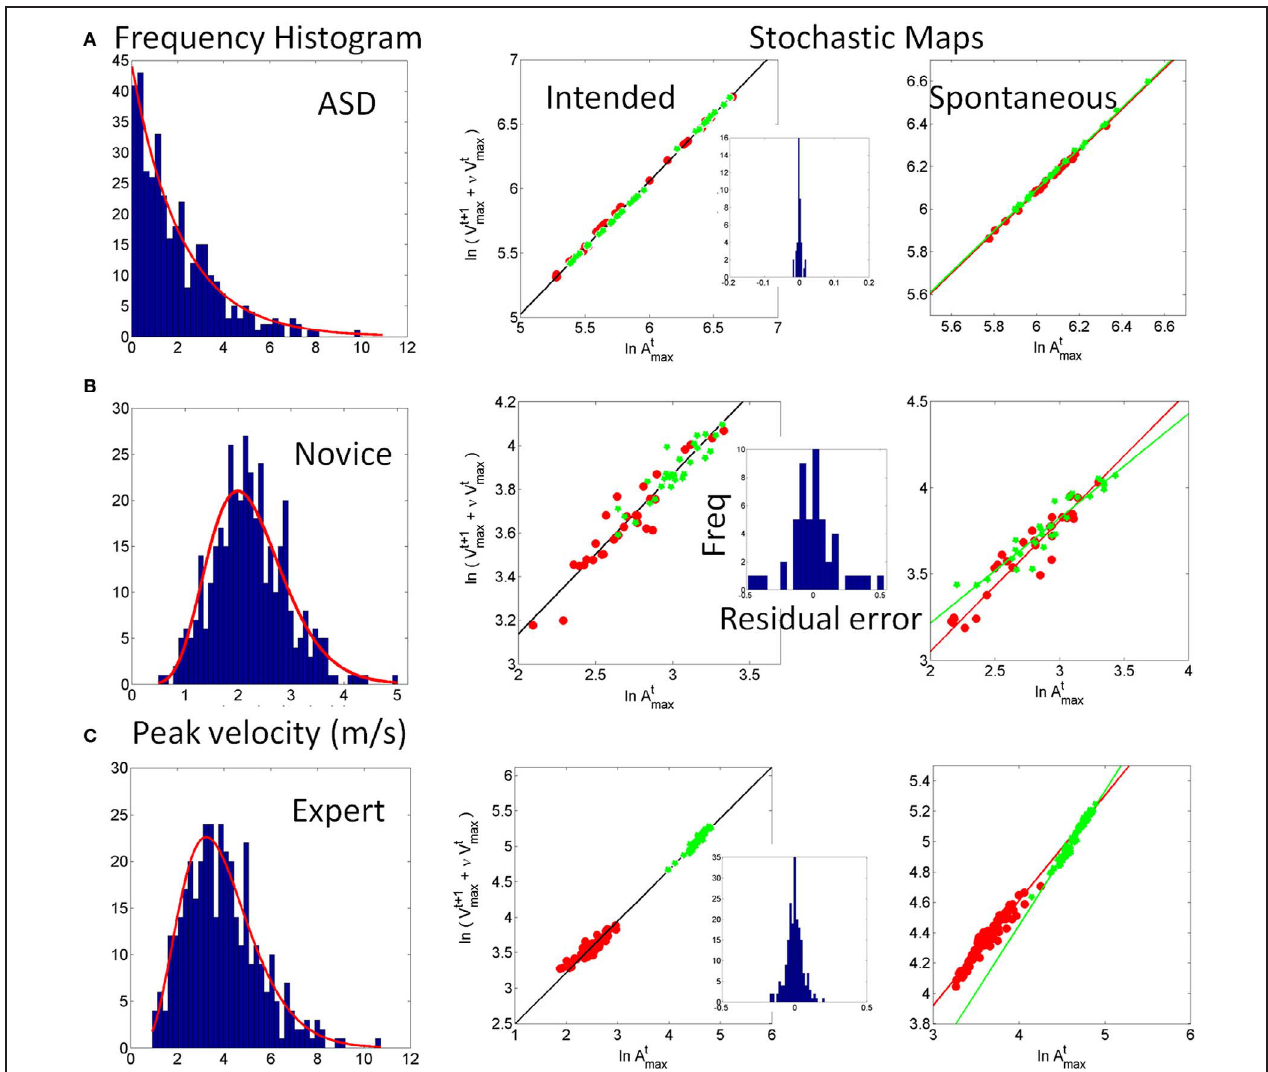
FIGURE 1 | The concept of motor variability revisited. An example that lower movement variability in our framework does not necessarily mean better performance. (A) Frequency histogram of the peak velocity from JAB boxing strikes performed by an individual with ASD are well-fit by the Exponential distribution (lowest bin centered at 0.16m/s). Simple speed-acceleration dependent first-order stochastic map used to describe the noise of the performance and to characterize the anticipatory nature (or lack thereof) in speed variability across trials [explained in Torres (2013)]. Each dot represents a trial, red is slow and green is fast. Each speed in trial n + 1 depends on the speed and acceleration from trial n . The decay parameters of the best fitting relation tend to be well-characterized by a power law and the exponent is generally similar for fast and slow speed when the motion is intended (as in the JAB’s strike). The ASD participant had nearly zero noise in the residual error from the fitting and his motions did not group according to speed level as did those from the novice (B) and expert (C) . In his case the low variability made his motions non-anticipatory of impending speed. Furthermore, the performance was “memoryless” as past speeds did not contribute to the accurate prediction of present speeds and present events did not contribute to the accurate prediction of future speeds. In the panel of spontaneous retractions (reported by the subjects to be beneath their awareness) the ASD performance cannot distinguish speeds